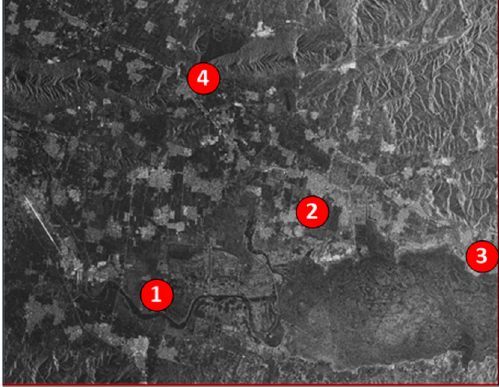
Figure 14. Scattering points in SAR image